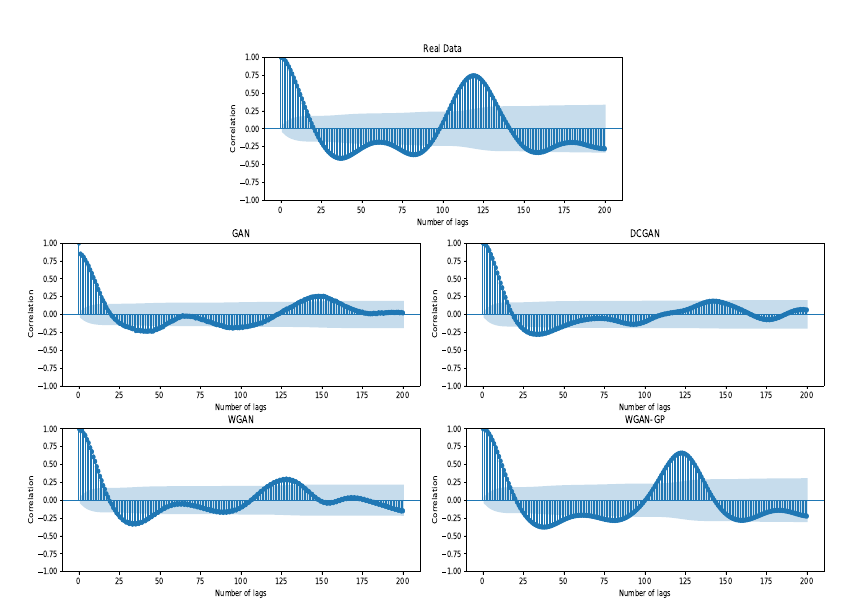
Figure 5. The auto-correlation plots of generated wrist pulse signals with different GAN models. In the figure, the real pulse data are shown above, and the false pulse generated by the corresponding GAN model is shown below.